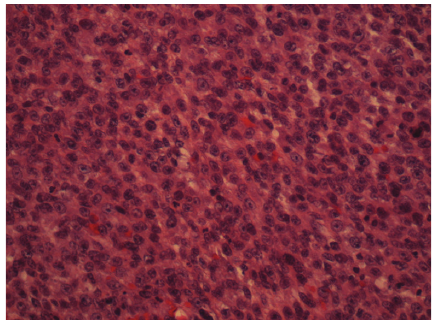
Figure 6: Undifferentiated sarcomatous cells in parotid specimen. H&E ×